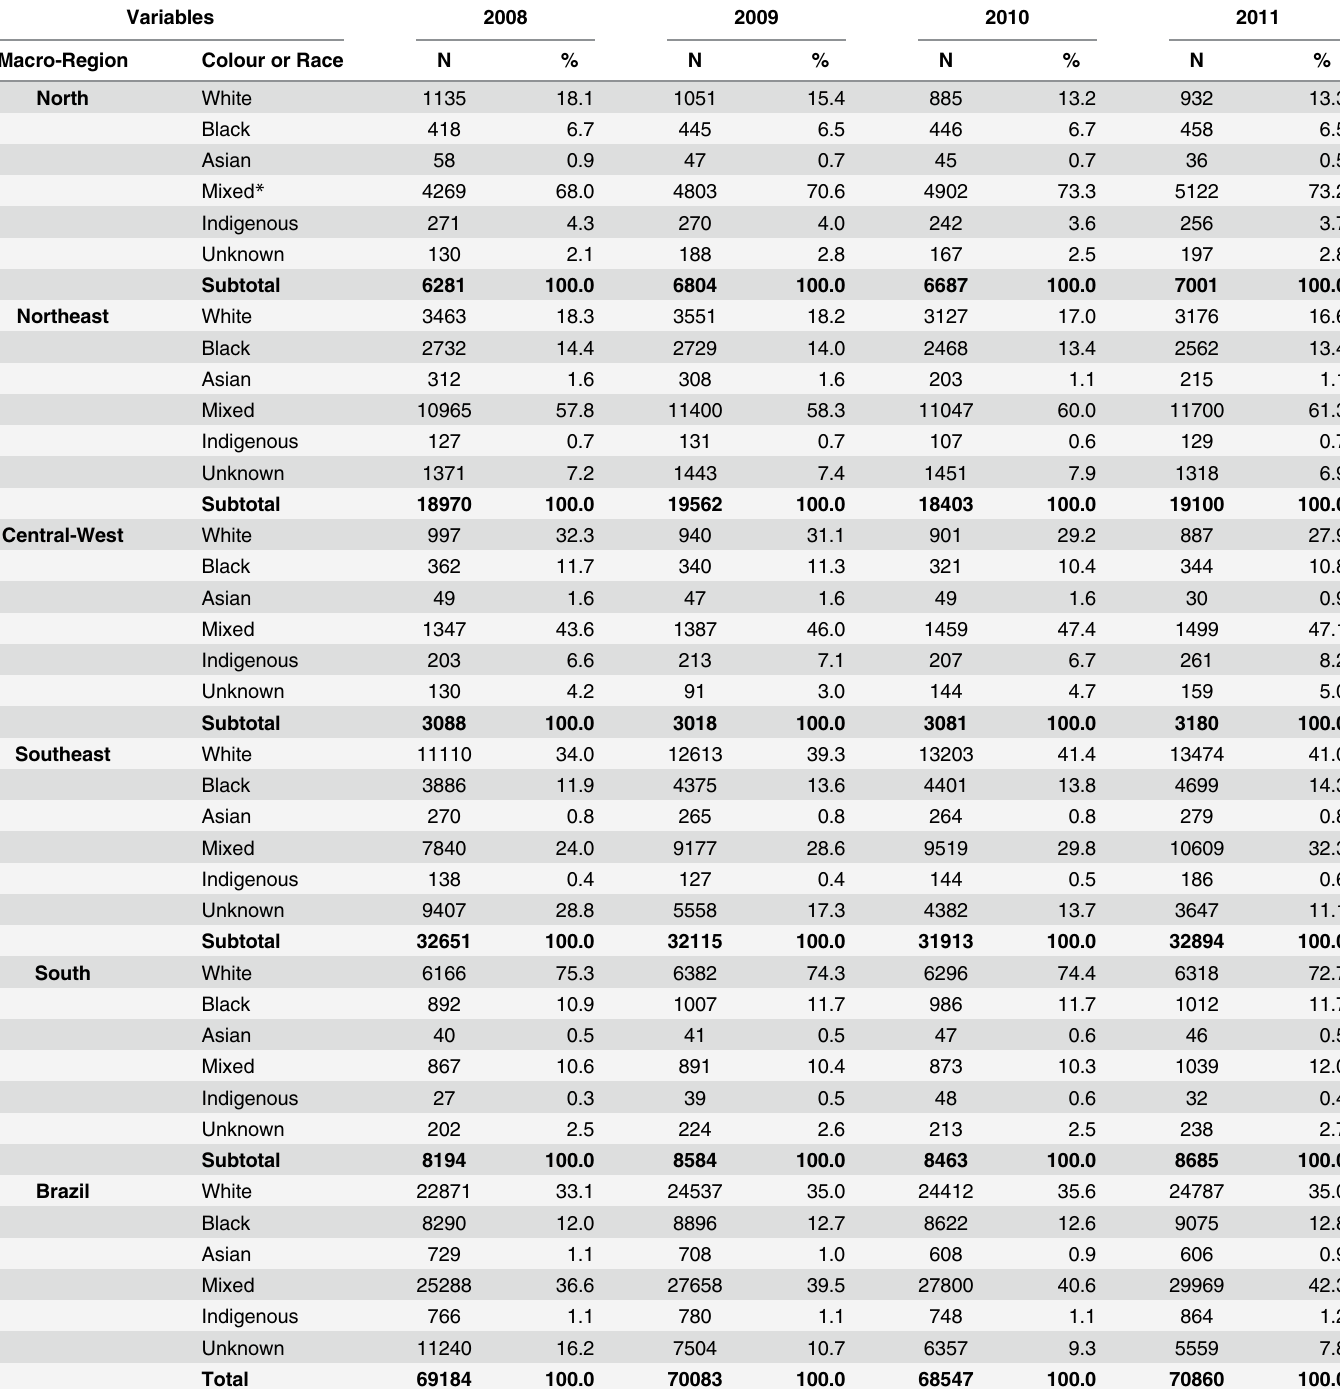
Table 1. Annual Distribution of Notified New Cases of Tuberculosis in Brazil, by Macro-Region and Colour or Race, in the Period 2008 – 2011. Source: Sinan-TB/MS. Note: * In Brazil, the Mixed race category is called Pardo, which means a mixture of European, Black and Amerindian. Variables 2008 2011 Macro-Region Colour or Race N North White